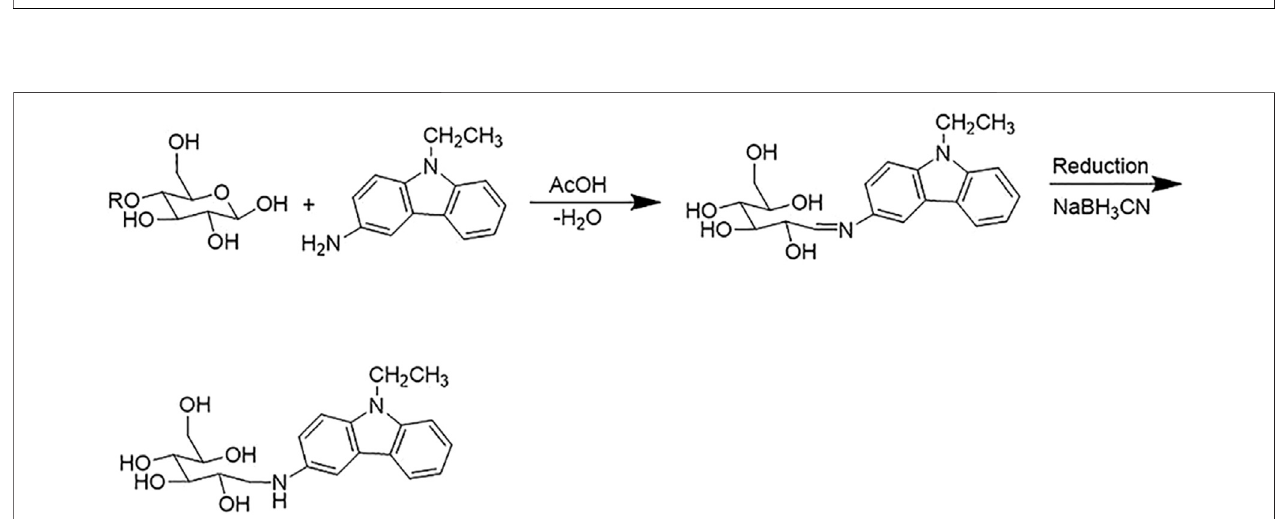
FIGURE 8 | The reaction mechanism of AEC with sugars in